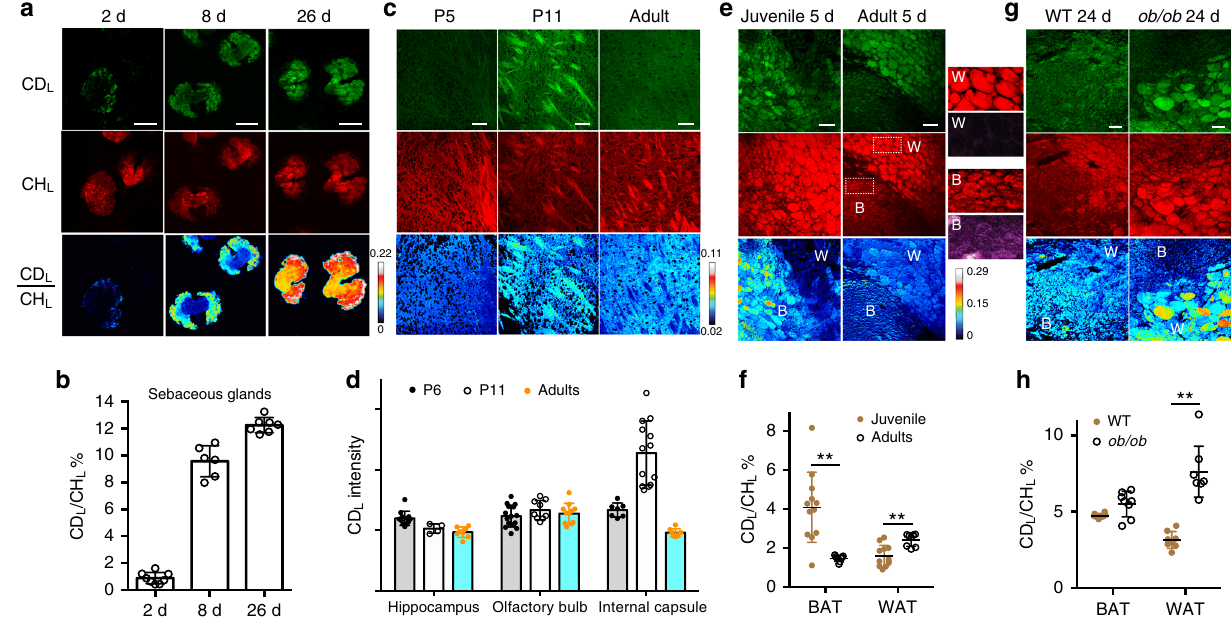
Fig. 5 DO-SRS microscopy visualizes de novo lipogenesis in mice in vivo. a , b Ear skins were harvested from adult mice drinking 25% D 2 O for 2, 8, or 26 days, and the sebaceous glands were imaged from the CD L and CH L channels, from which signals were color-coded in green and red, respectively. The ratios of CD L mean intensity to CH L mean intensity across an entire gland unit were quanti fi ed. Mean ± s.d. is plotted; N = 8, 6, and 7 for 2-, 8-, and 26-day treatment, respectively. c Internal capsule of the mouse brain from P5 (5 days postnatal) and P11 pups and adults were sectioned and imaged. Pups were fed on milk produced by mother mice drinking 25% D 2 O for 6 days before imaging, and adults drank 25% D 2 O for 9 days before imaging. d Quanti fi cation of myelination activities in different brain regions. CD L signal was quanti fi ed as the mean intensity (mean ± s.d.) of the entire image; N is between 8 and 14. e , f White and brown adipose tissues from juvenile (P25) and adult (3-month old) mice drinking 25% D 2 O for 5 days were imaged. Difference between WAT ( ‘ W ’ ) and BAT ( ‘ B ’ ) is shown, as an example, by the enlarged regions (dashed square) of the adult tissues; fl uorescence signal excited at 488 nm and collected at 525 nm is shown in purple. g , h Adipose tissues from wild-type and ob/ob adult mice that drank 25% D 2 O for 24 days. For quanti fi cation in f , h , mean ± s.d. is shown. Double asterisks indicate p < 0.01 in an unpaired t test. Three mice were used for each condition, and three or four fi elds were imaged for each tissue. Scale bar = 20 μ m for the entire fi gure. The color scale bars represent the scale for CD L /CH L